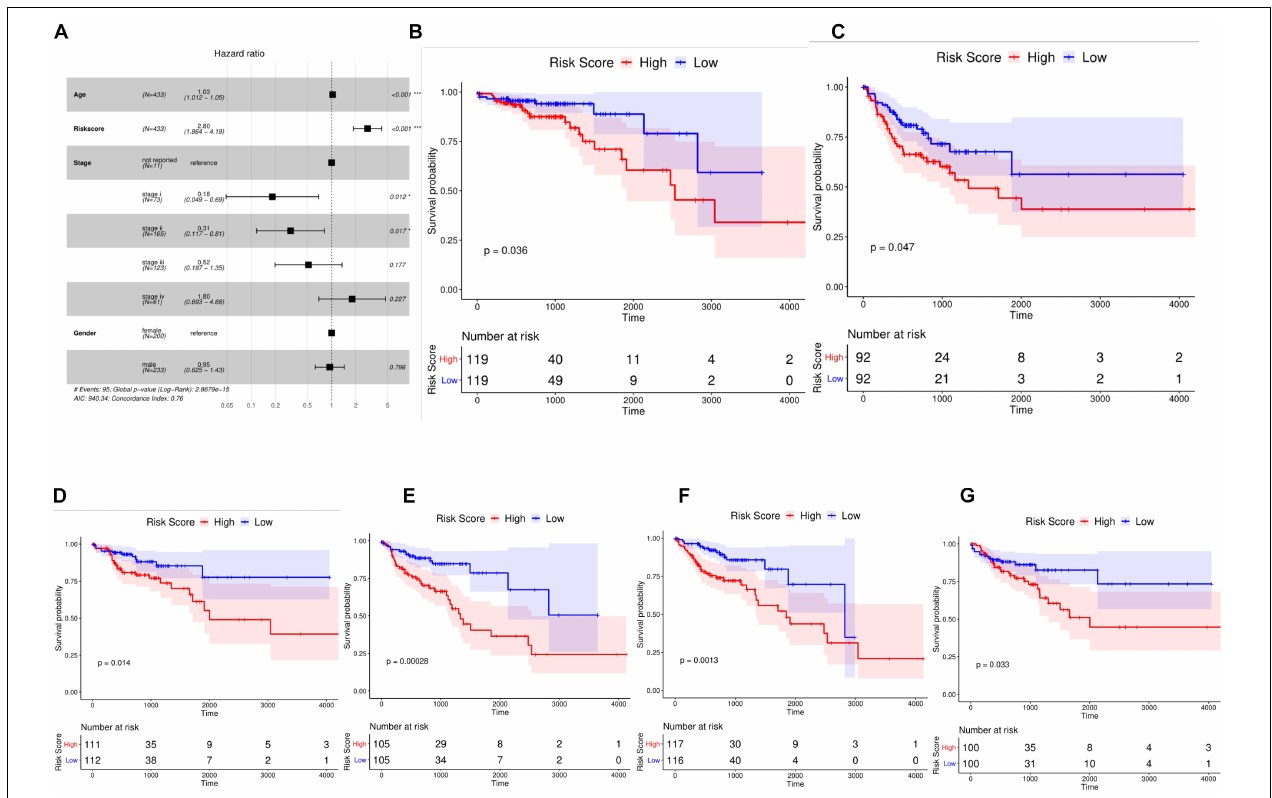
FIGURE 4 | Risk score was independent prognostic marker for colon cancer. (A) Multivariate Cox regression analysis of forest plots. Compared with reference samples, samples with Hazard ratio greater than 1 had higher risk of death. Samples with Hazard ratio less than 1 had a lower risk of death. (B,C) Kaplan Meier survival curves of colon cancer samples with different Stage stages. (D,E) Kaplan Meier survival curves of colon cancer samples from different age groups. (F,G) Kaplan survival curves of colon cancer samples from different sexes.